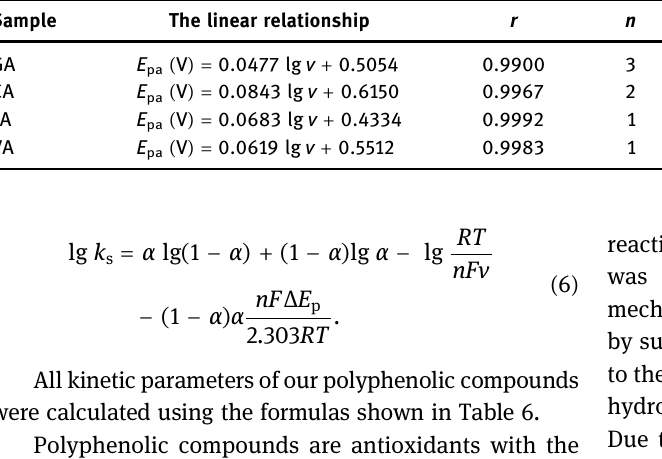
Table 6: The determination of kinetic parameters of four polyphenolic compounds Sample